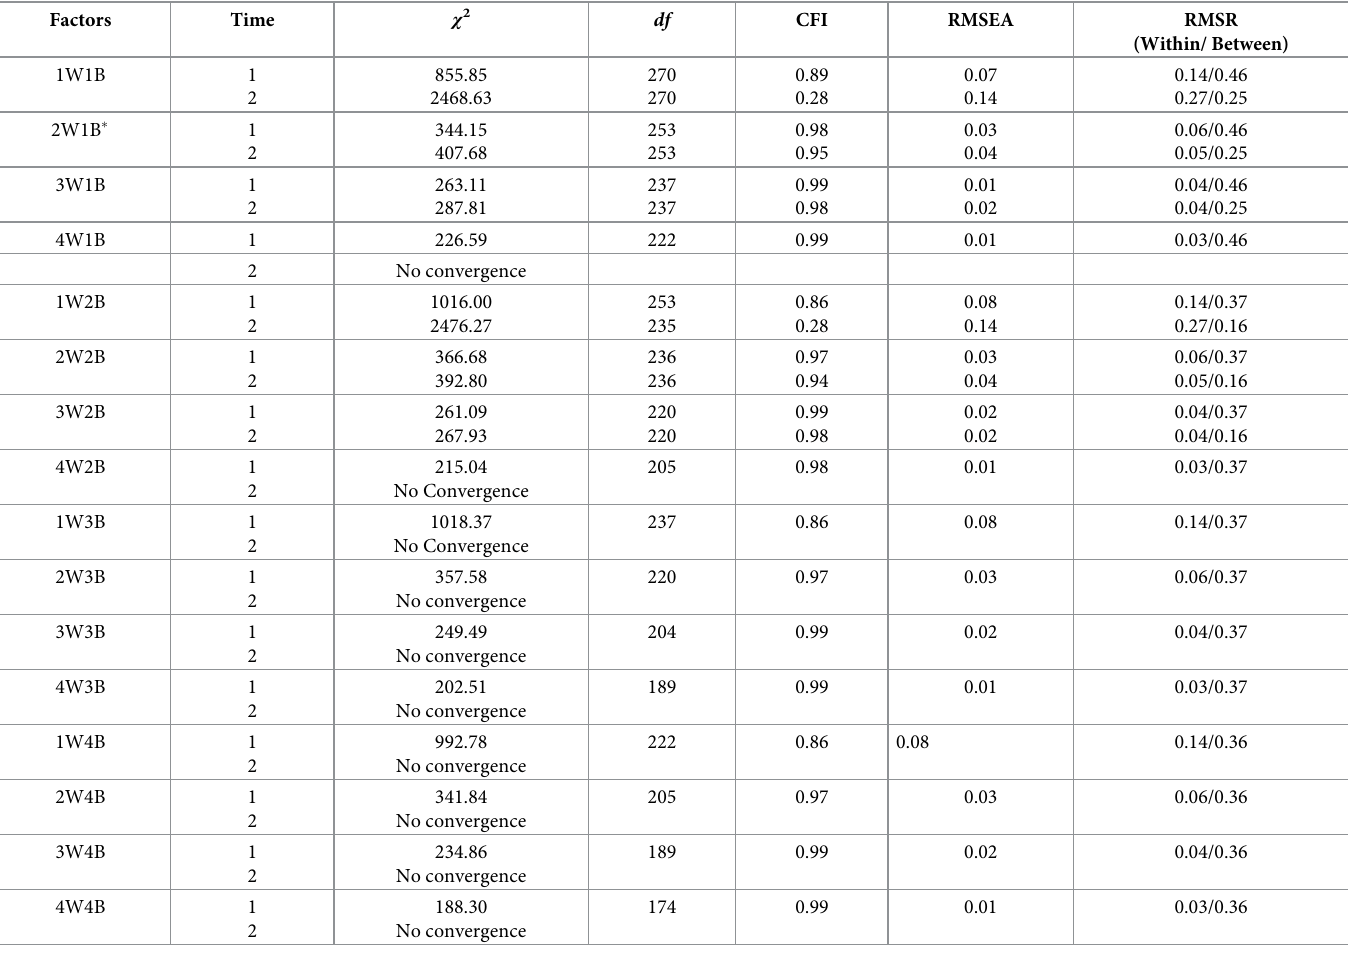
Table 5. Overall model fit for multilevel exploratory factor analysis for 18 items at Time 1 and Time 2.